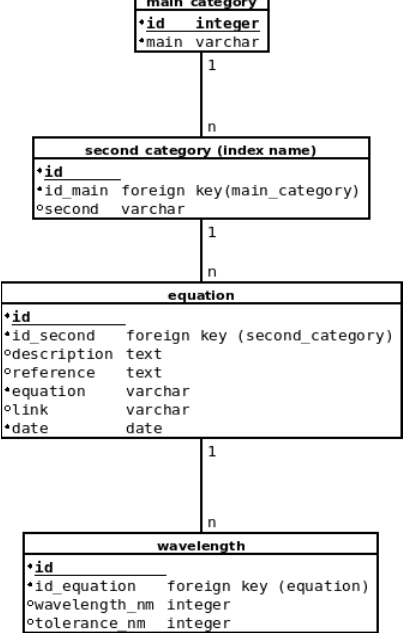
Figure 1. Entity-Relationshiop diagram for the spectral indices